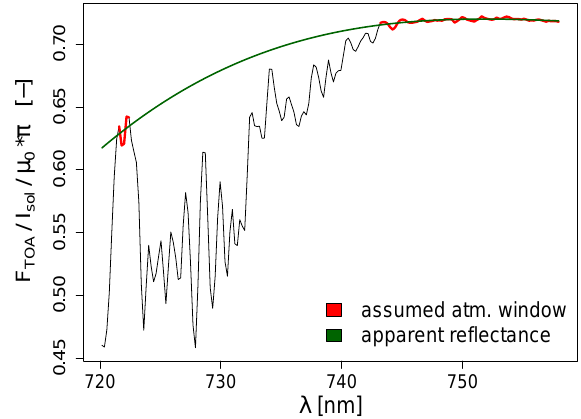
Figure 2. Estimation of apparent reflectance (green) from a sam- ple GOME-2 measurement in the 720–758nm fitting window by a third-order polynomial using atmospheric windows